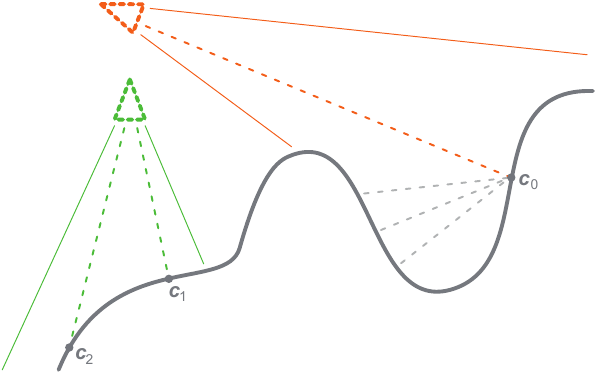
Fig. 4 Self shadowing and limited range of the projectors can lead to artifacts. c 0 can only receive interreflecting light from the opposed surface if this surface is actually lit. Furthermore, the surface geometry influences the reachable surface illumination. While c 1 is fully lit, c 2 is attenuated due to Lambert’s Law.